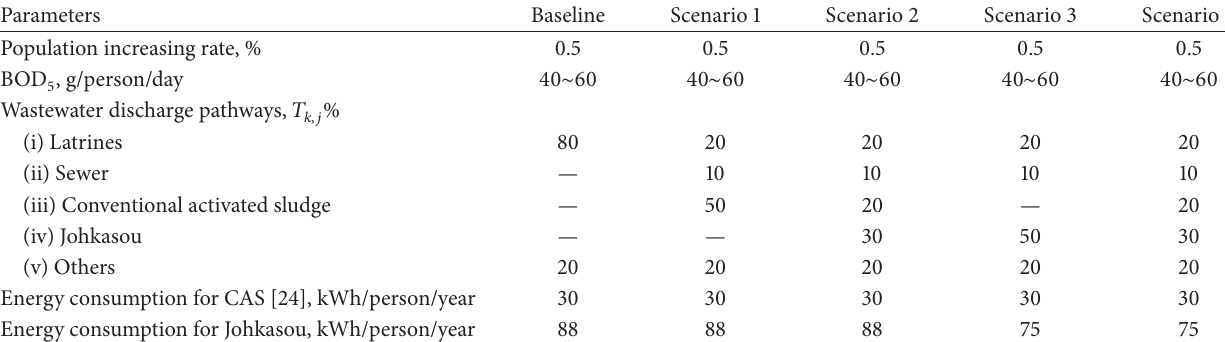
Table 3: Scenarios description and model input